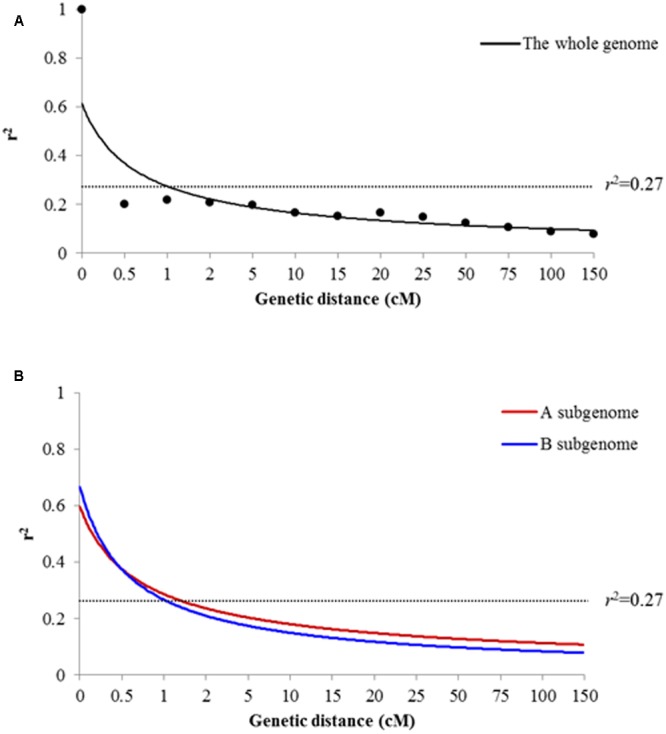
Linkage disequilibrium (LD) decay for all the 104 accessions. (A) Genome-wide LD decay of the whole genome for the peanut panel. (B) LD decay of the A and B subgenomes for the peanut panel.